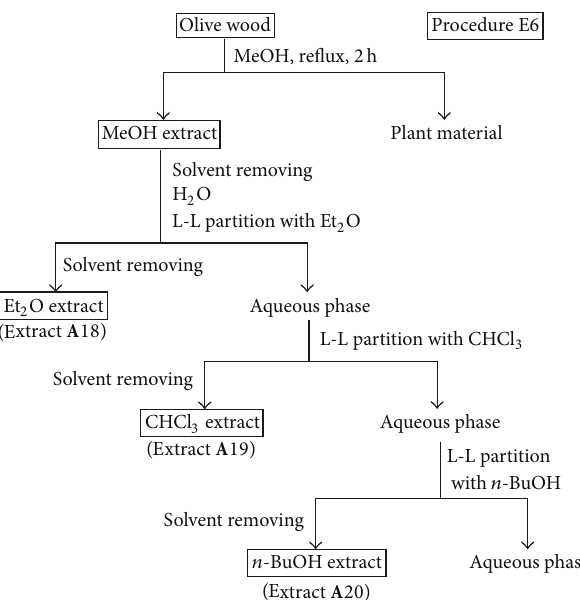
Figure 6: Solvent extractions of olive wood sample A following procedure